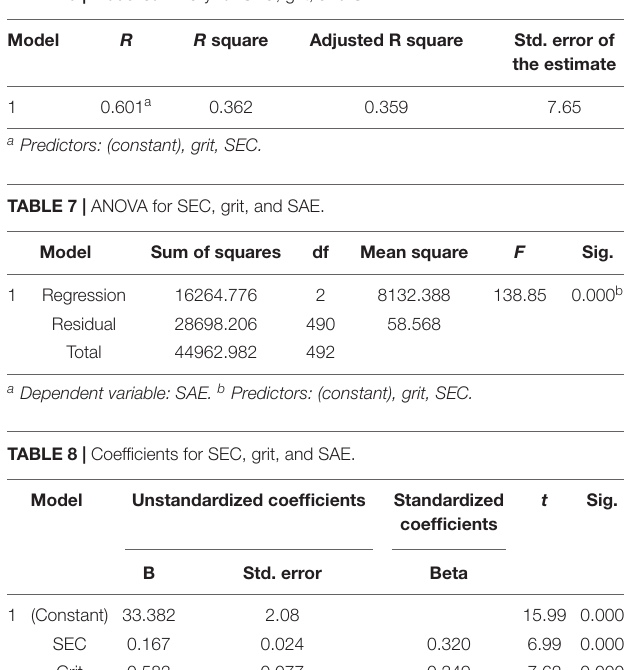
TABLE 6 | Model summary for SEC, grit, and SAE.